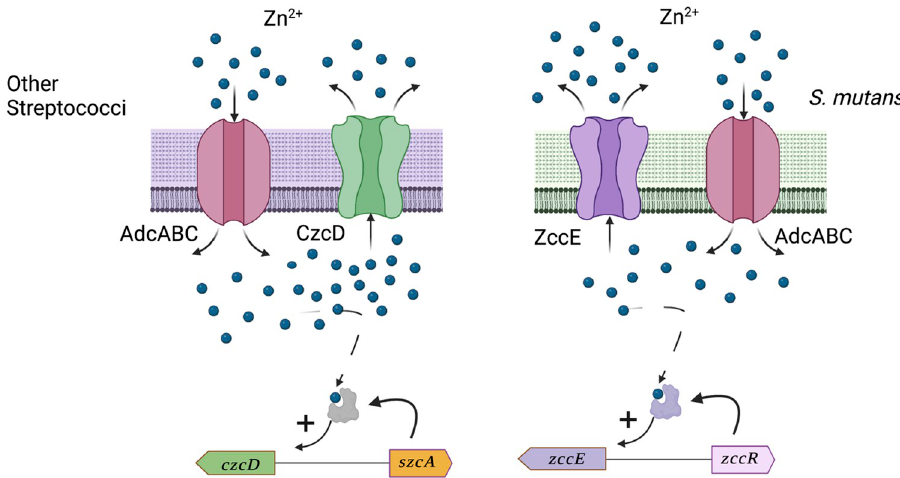
Fig 11. Model figure showing that ZccE (a P-type ATPase transporter) and CzcD (a CDF-type transporter) mediate high Zn tolerance in streptococci. Both czcD and zccE encode for Zn efflux systems and each system is positively regulated by cognate transcriptional regulators (SzcA for czcD and ZccR for zccE ) that are activated under high Zn conditions. The CzcD/SzcA pair is found in most streptococci while ZccE/ZccR is unique to S . mutans and, based on Zn sensitivity assays and mutational analysis, is directly responsible for the exceptionally high Zn tolerance of S . mutans when compared to other streptococcal species. AdcABC is an ABC-type transporter conserved among streptococci and primarily responsible for Zn import. This figure was created with